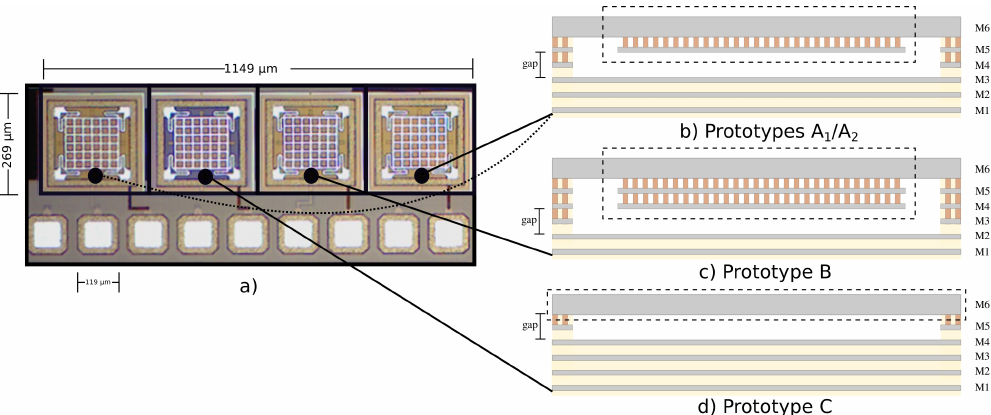
Figure 3. CMOS-MEMS prototypes fabricated in 180 nm standard CMOS technology and cross-section scheme of each prototype. ( a ) Microphotograph of the chip developed for the prototyping and testing of the resonant sensors. ( b ) Structural scheme of prototypes A 1 A 2 . ( c ) Structural scheme of prototype B, where the resonant plate is formed by three metals. ( d ) Prototype C, where the resonant plate is formed solely by the upper metal. Each prototype has two pads ( V drive and V sense ) and one common to all ( gnd )